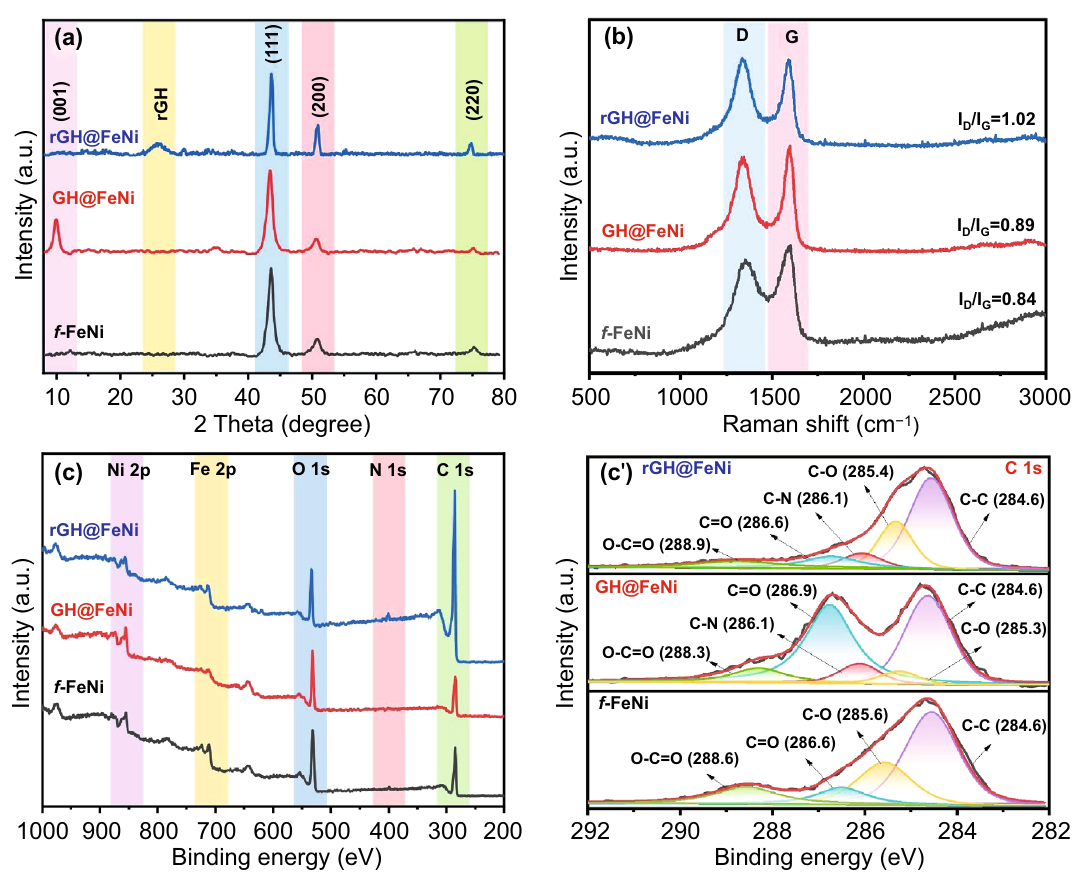
Fig. 2 XRD ( a ), Raman ( b ), XPS spectra ( c ) and high-resolution C 1 s ( c ′ ) of f -FeNi, GH@FeNi and rGH@FeNi aerogel (rGH 1.2 wt%, f -FeNi 0.9